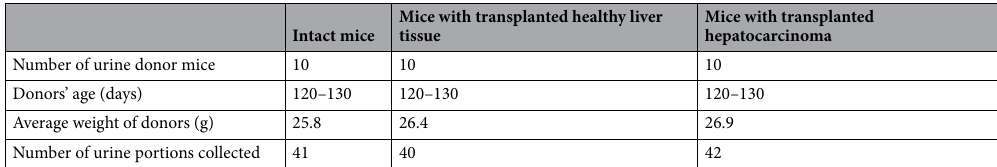
Table 2. The composition of the groups of mice and the number of samples collected for the MS